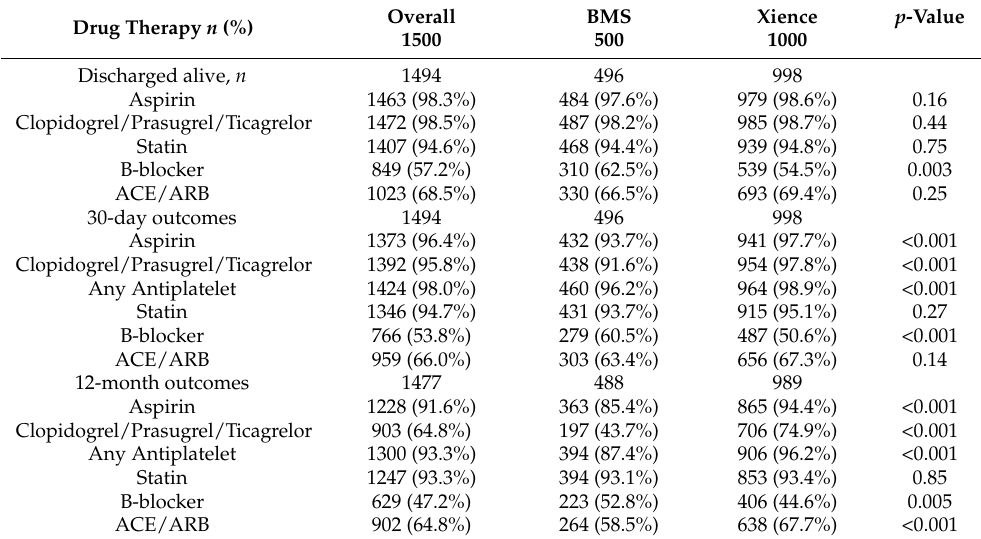
Table 5. Discharge and 1-Year Medication Compliance